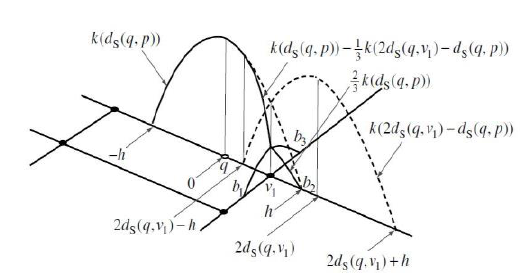
Figure 5. Equal-split continuous kernel function (Okabe et al., 2009):